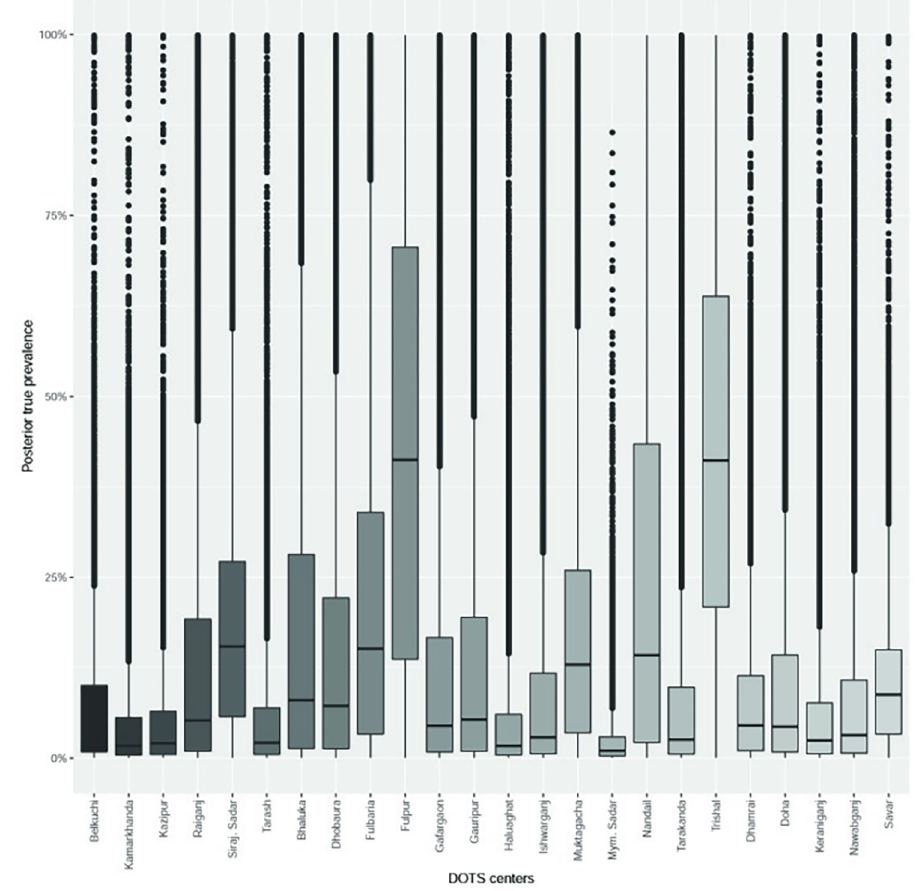
Fig 1. Boxplots showing the DOTS centers level true prevalence of TB among suspects in Mymensingh, Sirajganj and Dhaka districts of Bangladesh.